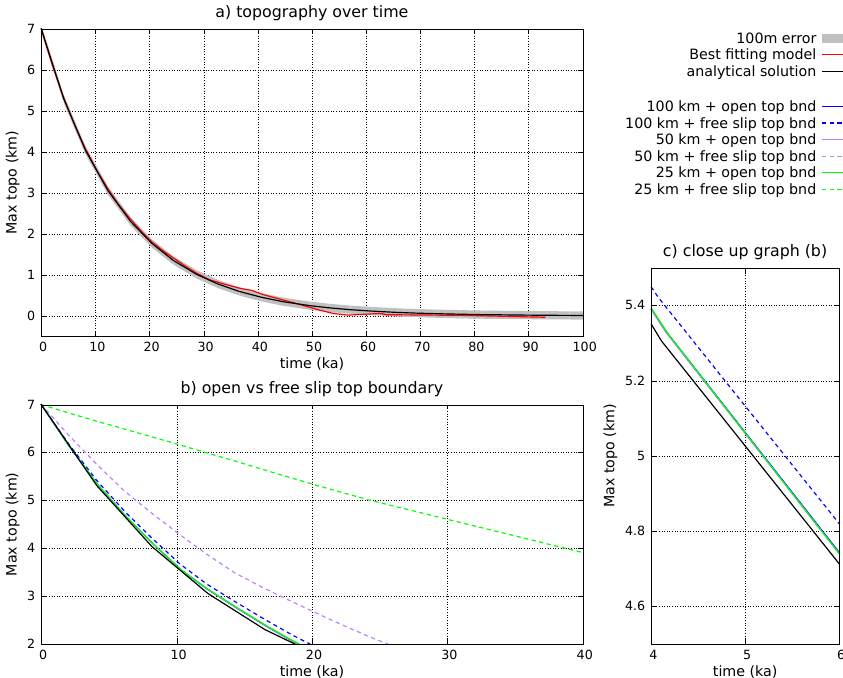
Figure 4. (a) The topography over time of our best fitting model run. (b) The data of open vs. free slip top boundaries for different sized sticky air layers. The solid green, purple and blue line exactly overlap. Confirmed by the close-up in (c) . (c) Contains a close-up of (b) showing that the three open boundary model runs (solid lines) do indeed yield exactly the same result.